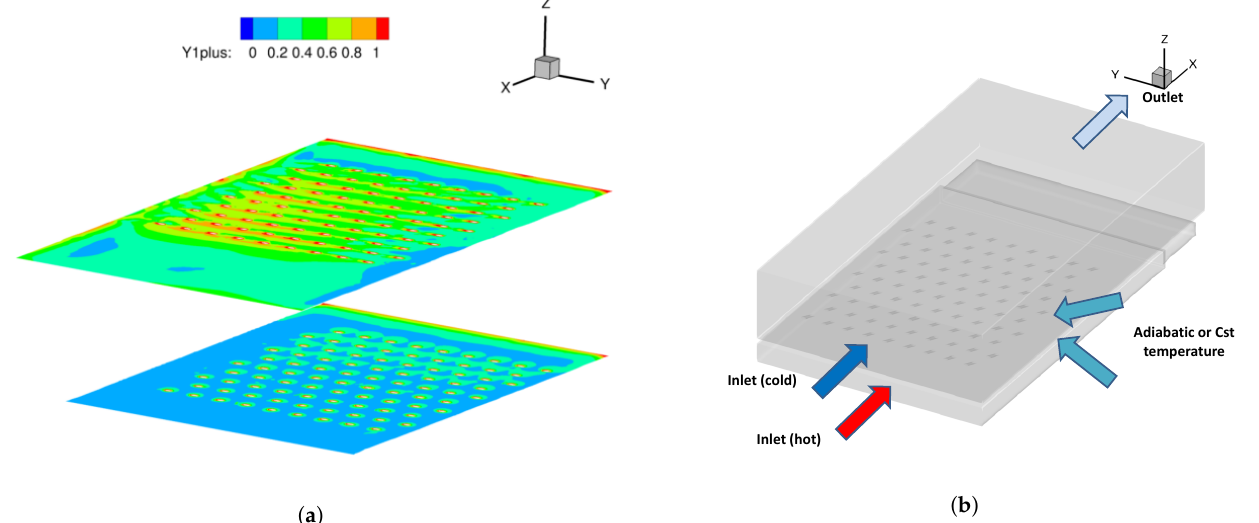
Figure 11. Numerical conditions—Mesh quality and boundaries. ( a ) y + distribution near the hot (bottom) and cold (top) sides of the plate; ( b ) Boundary conditions